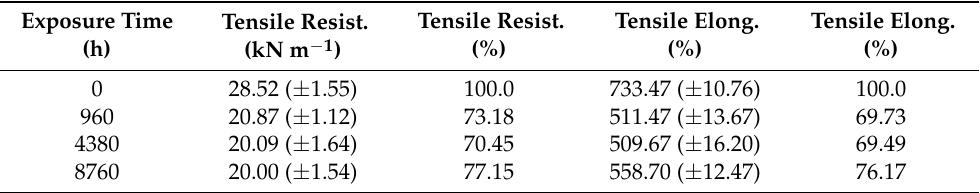
Table 3. Tensile at break test results after UV fluorescent device exposure.